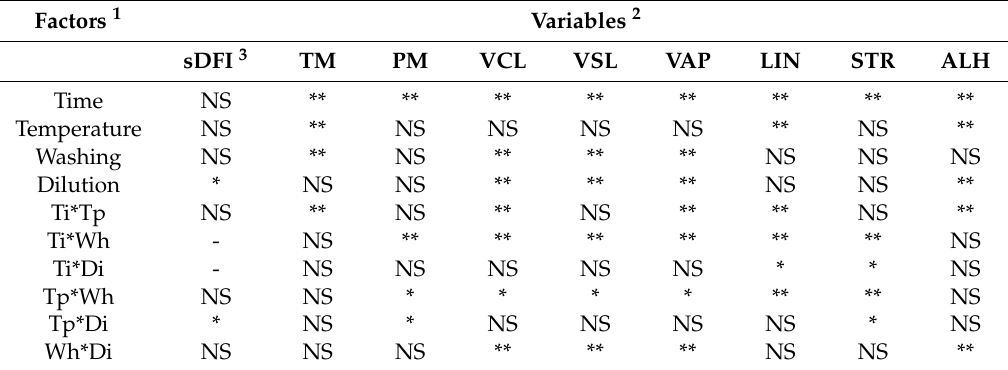
Table 3. Significance levels of factors for variables studied in Experiment 2.